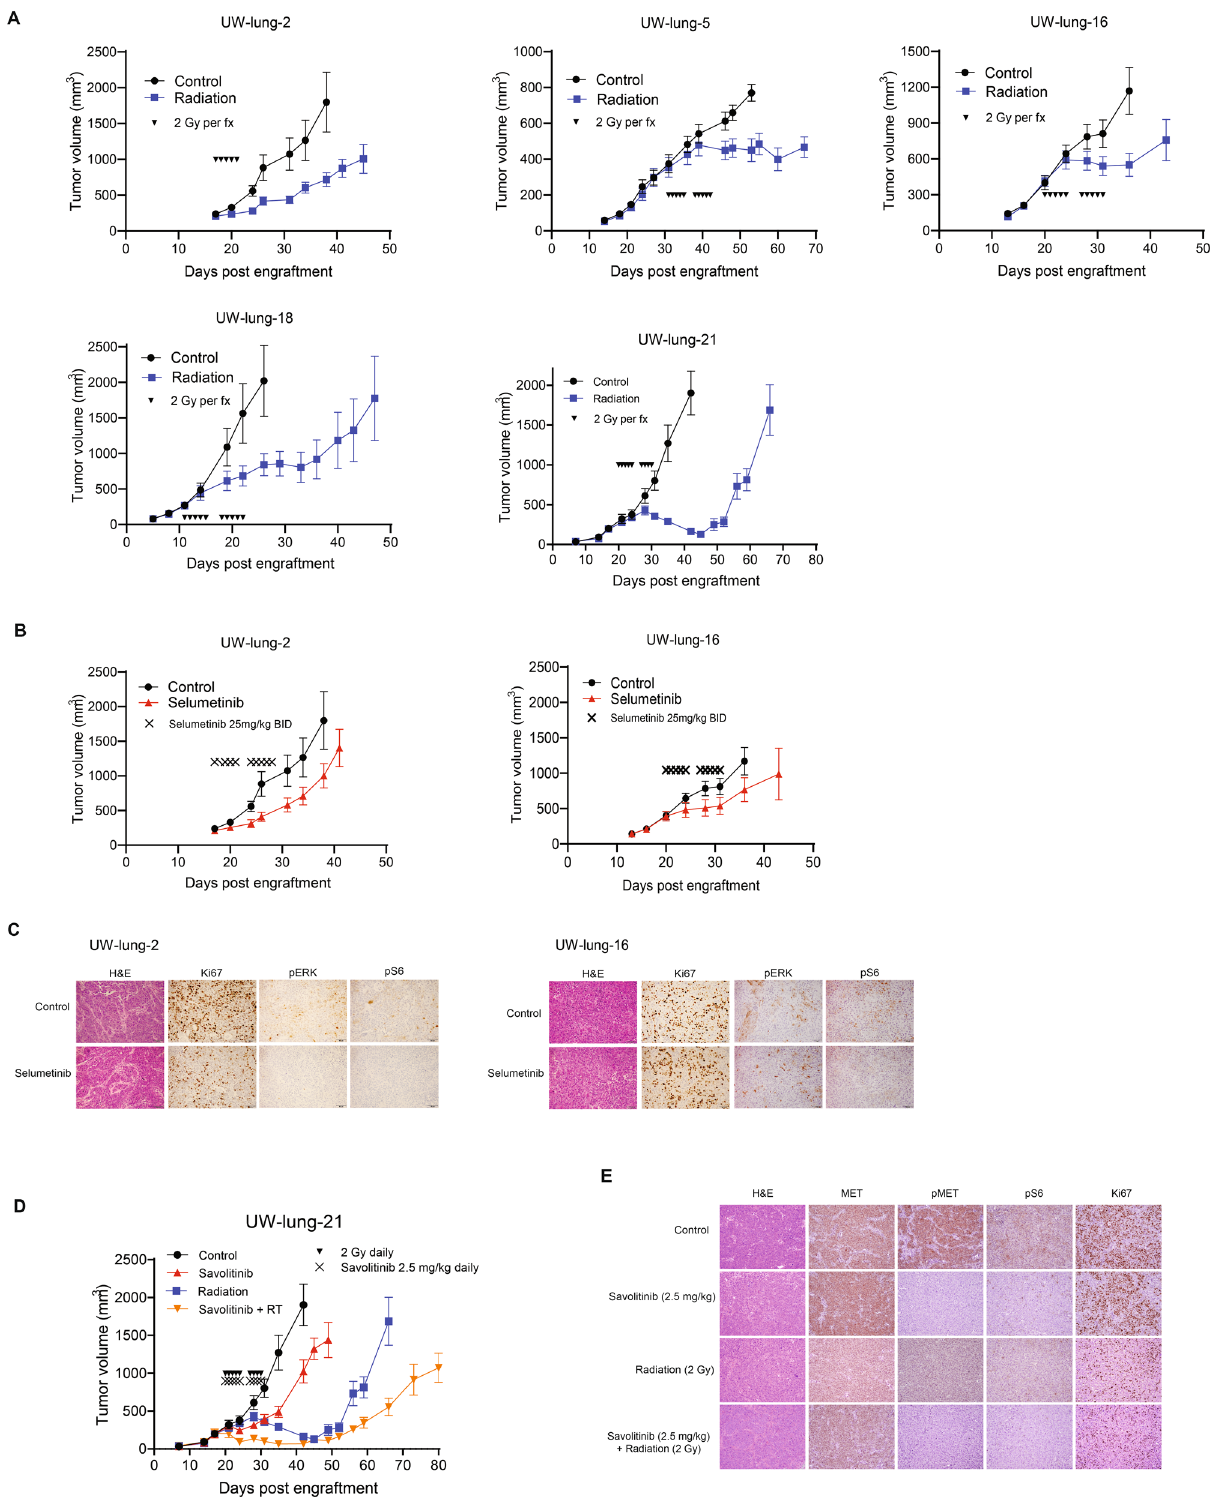
Figure 6. Therapeutic effects of radiation, selumitinib and savolitinib on xenograft growth delay. ( A ) Radiation-induced tumor growth delay curves of UW-lung-2, UW-lung-5, UW-lung-16, UW-lung-18 and UW-lung-21. Radiation was given as 2 Gy per fraction for either 5 days or 10 days as indicated. ( B ) KRAS G12C mutated UW-lung -2 and UW-lung-16 subcutaneous flank xenografts treated with vehicle or selumitinib 25 mg/kg BID for 10 days. ( C ) Immunohistochemistry of UW-lung-2 and UW-lung-16 tumor sections showing modulation of KRAS-downstream signaling (p-Erk and p-S6) following a one-time dose of 25 mg/kg BID of selumitnib, collected at 24 h. ( D ) MET exon 14 mutated UW-lung-21 subcutaneous flank xenografts treated with vehicle, savolitinib 2.5 mg/kg, radiation or radiation plus savolitinib 2.5 mg/kg for 10 days. ( E ) Immunohistochemistry of UW-lung-21 tumor sections showing modulation of MET signaling (MET, p-MET, p-Erk and p-S6) and decrease in Ki-67 following a single dose of 2.5 mg/kg of savolitinib, collected at 24 h. Points, mean tumor volume in mice after treatment; bars, SEM. The scale bar represents 50 mm and all images are to the same